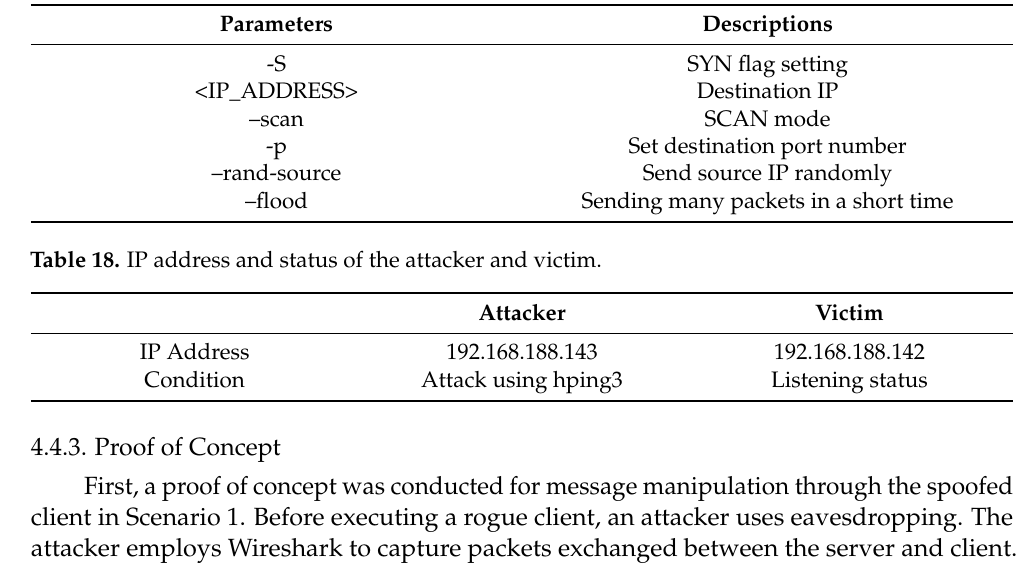
Table 17. Main parameters and their descriptions for hping3.